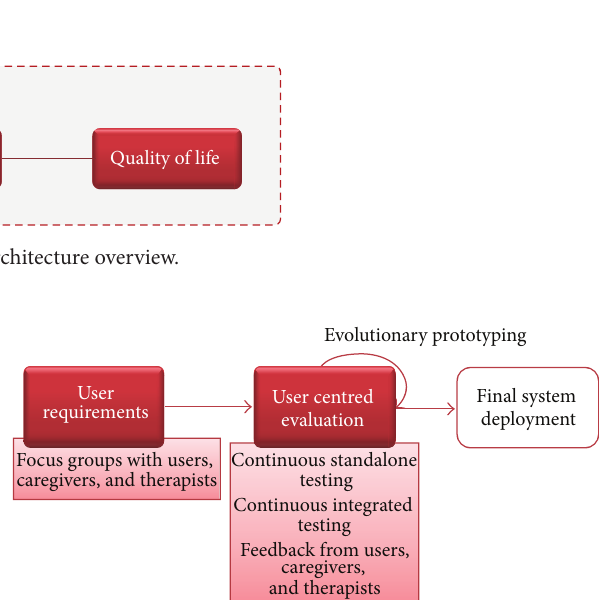
Figure 2 sketches the adopted approach: first user